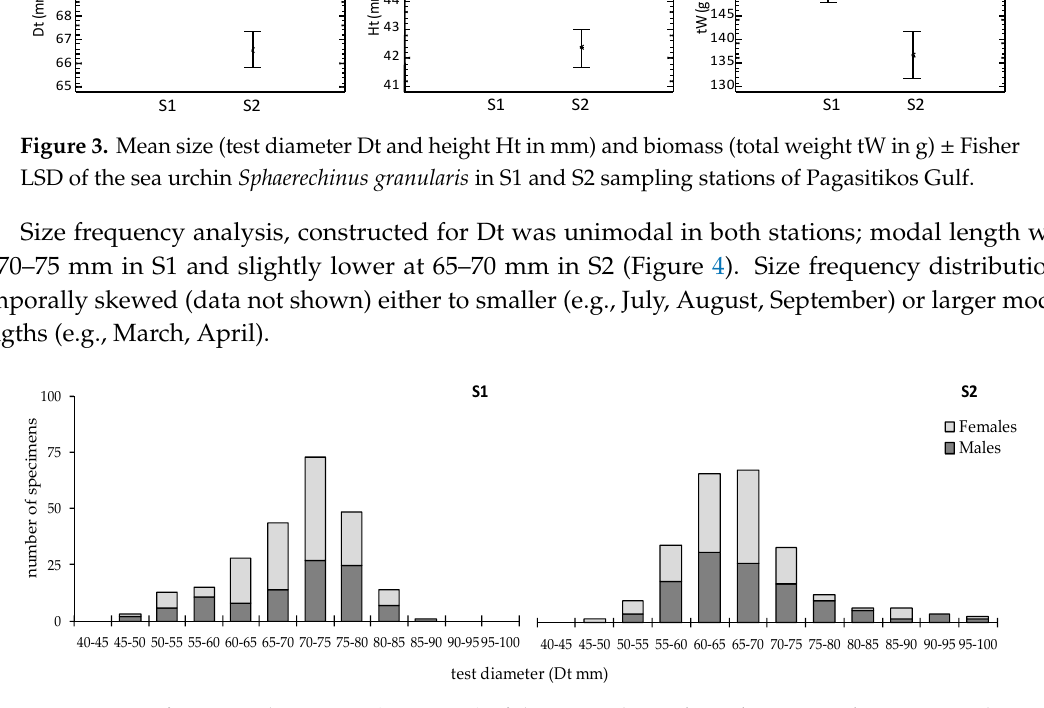
Figure 4. Size frequency histogram (Dt in mm) of the sea urchin Sphaerechinus granularin in S1 and S2 sampling stations of Pagasitikos